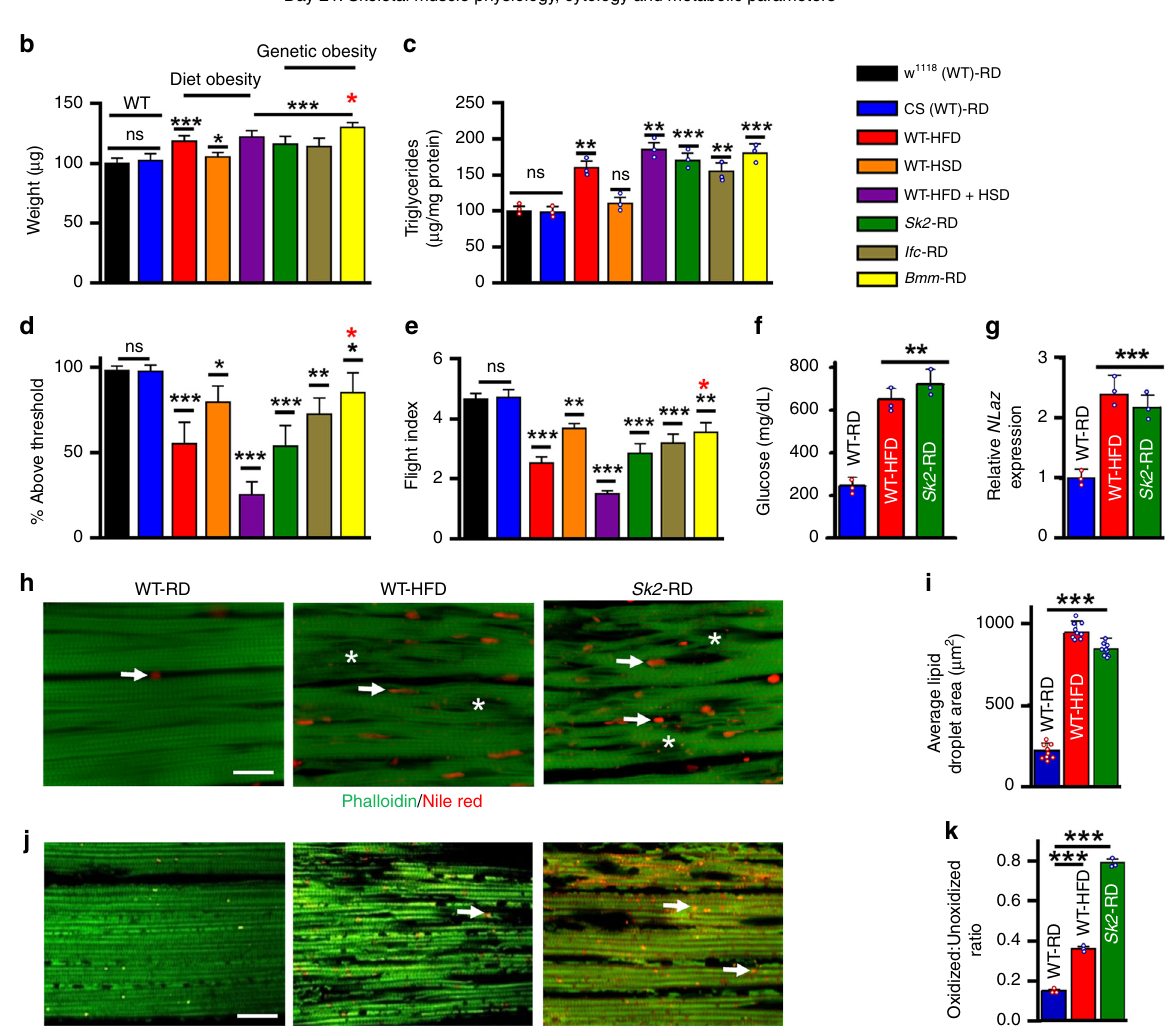
compared with RD fl ies (Fig. 1h, i). and promotes the production of reactive oxygen species 36 . We measured oxidative mitochondrial stress of skeletal muscle from 3-week-old fl ies using the MitoTimer reporter gene (Fig. 1j, k). The MitoTimer reporter expresses a mitochondria-speci fi c protein that irreversibly changes fl uorescence from green to red upon oxidation 37 . Red punctae were clearly visible in cryosec- tioned fl ight muscles of HFD and Sk2 mutants (Fig. 1j), suggesting the induction of oxidative mitochondrial damage. Red-to-green ratios of female HFD and mutant Sk2 fl ies increased by ≥ 2.4 fold (Fig. 1k). NATURE COMMUNICATIONS| (2019) 10:2700